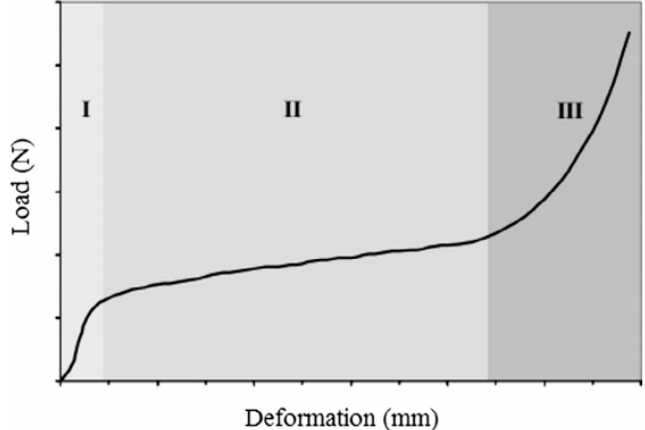
Figure 2. Typical profile of a force x displacement curve of a squeeze–flow test with displacement control. Source: Azevedo et al. [17].